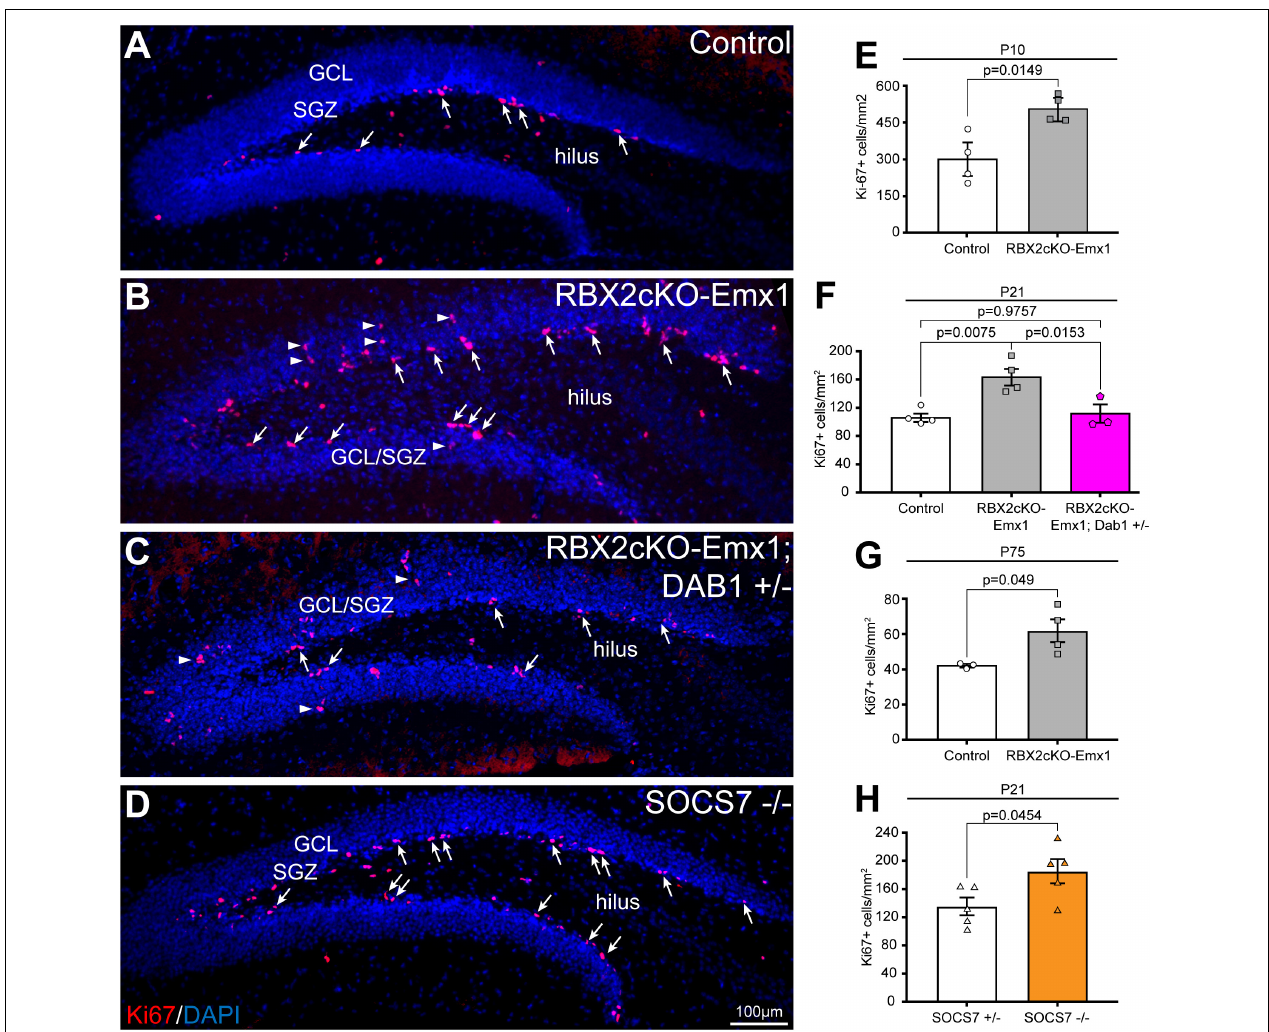
FIGURE 3 | RBX2 controls NSC proliferation in a Reelin/Dab1-dependent fashion. (A,B) Knocking out RBX2 promoted NSC proliferation, detected by Ki-67 staining (arrows), in comparison to control DG at P21. Arrowheads indicate Ki-67+ cells away from the innermost layer in the DG (C) reducing DAB1 levels in the RBX2 mutant DG rescues cell proliferation. (D) SOCS7 depletion showed the same levels of Ki-67+ cells (arrows). (D–F) Quantification of Ki-67+ cells in control ( Rbx2 fl/fl ) vs. RBX2cKO-Emx1 DG at P10 (E) , P21 also including RBX2cKO-Emx1; DAB1 +/– quantification (F) , P75 (G) , and of control (SOCS7+/–) and SOCS7 mutant (SOCS7–/–) DG at P21 (H) . Mean ± SEM. Statistics, unpaired Student’s t -test (E,G,H) and one-way ANOVA with Tukey’s method adjusted p -value (F)